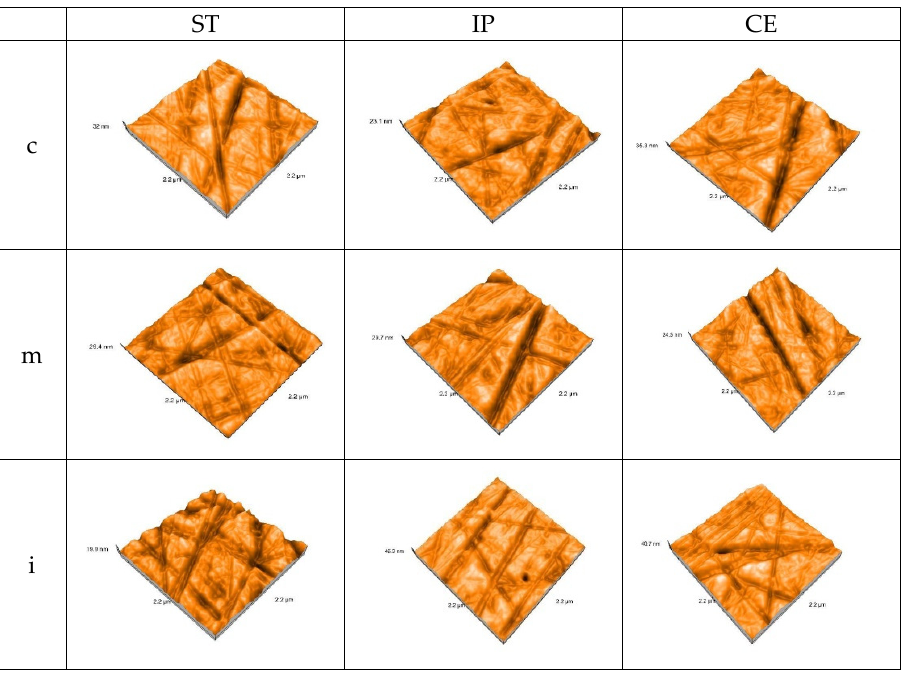
Figure 4. 3D AFM image of the polished samples of the control group. ST= STML, IP= IPS e.maxZirCAD CEREC/in Lab MT Multi, CE= CeramillZolidfx ML, c = cervical, m = medium, i = incisal. After aging, the values for Sa (nm)-arithmetical mean height and Sq (nm)-root mean square height resulted for the glazed samples and polished samples are shown in Table 7. Table 7. Sa, Sq values for aged-glazed and aged-polished samples, in each area (n = 8). ST ag